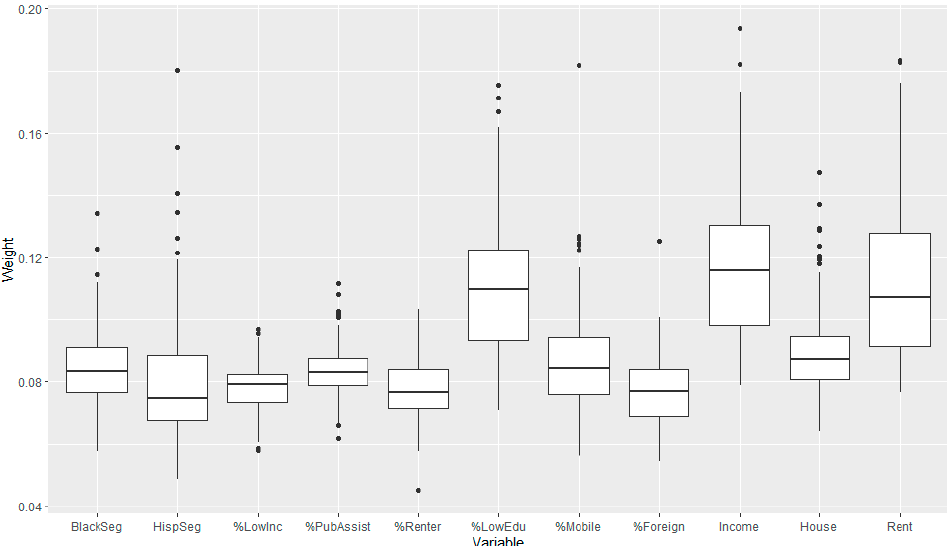
Figure 4. Distributions of neighborhood deprivation index component weights for the crude models for the 100 simulated datasets from the first sampling scheme for participants, where there are some large values above the body for most variables. Note: components are Black segregation, Hispanic segregation, percent of households with ratio of income to poverty <1 (below the poverty threshold), percent receiving public assistance income, percent of renters, percent with no high school diploma, percent in a different house than 1 year ago, percent foreign born, per capita income, median house value, and median gross